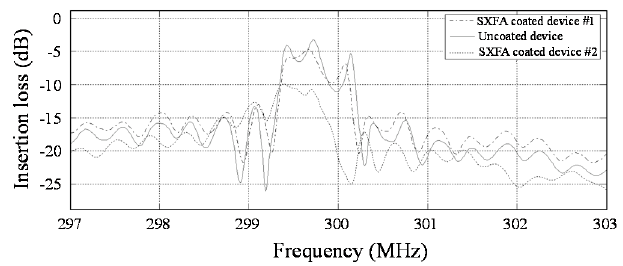
Figure 3. Measured frequency response of the prepared SAW sensing device before and after SXFA deposition (Device #1—50 nm, Device #2—200 nm).